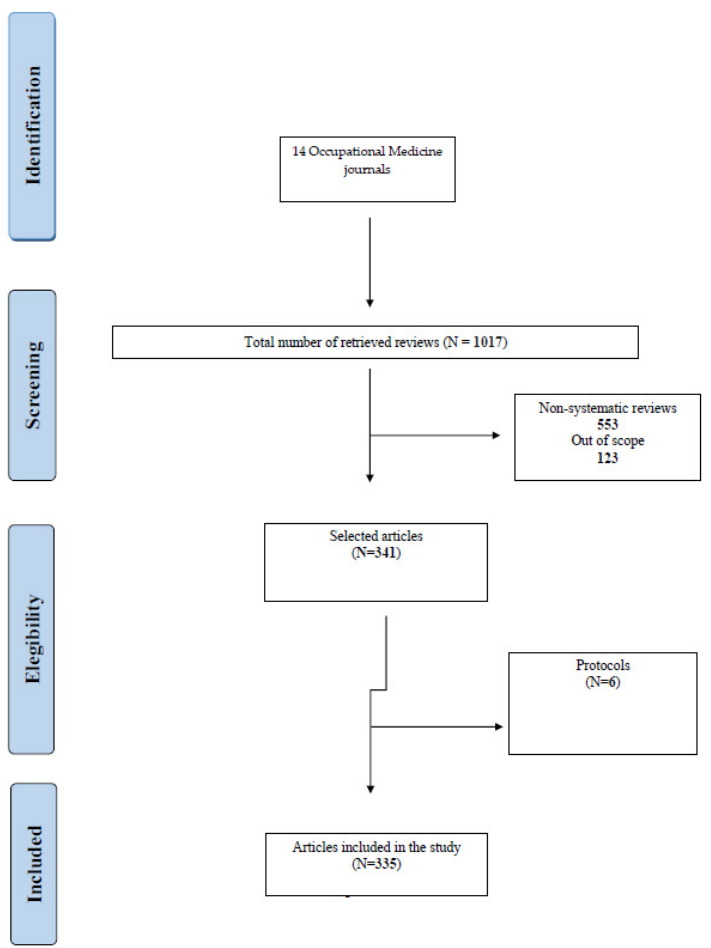
Figure 1. PRISMA flow-chart diagram of study selection.